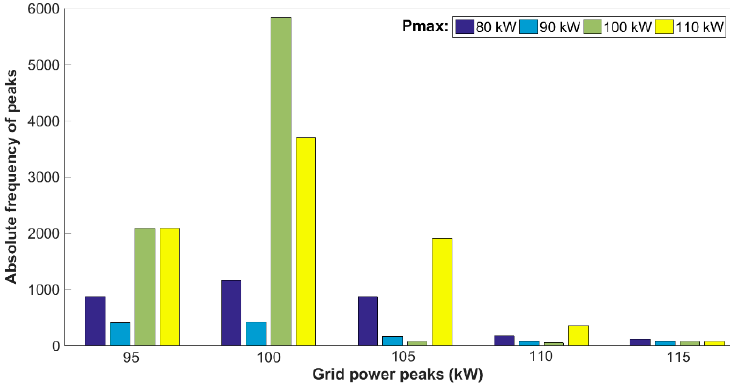
Figure 8. Histogram of yearly absolute frequency of grid power peaks with P max variations, C Bat : 250 kWh.